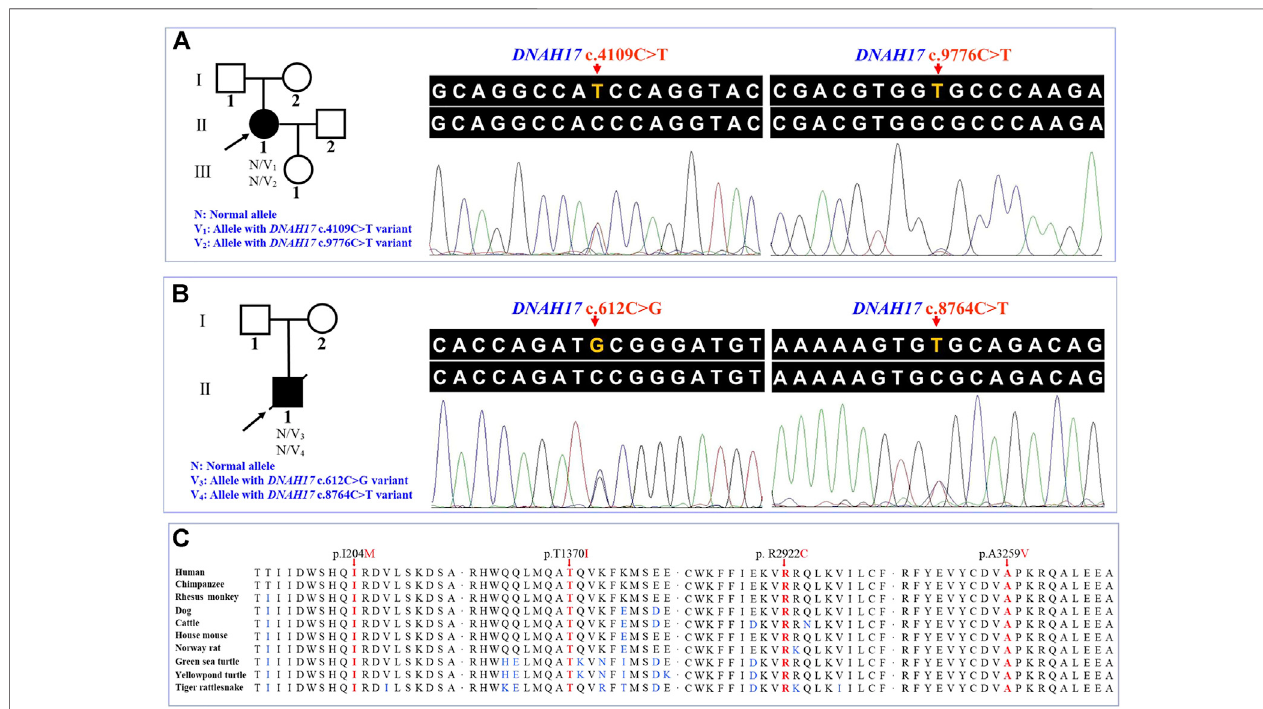
FIGURE 2 | Pedigrees and sequence analysis of the two unrelated Han-Chinese patients with left-right asymmetry disorders. (A) and (B) Pedigrees with left-right asymmetrydisordersandSangersequencingresults.Theproband,shownasasolidsymbol,isindicatedbyanarrow,andthedeceasedfamilymemberisshownwitha slash in the pedigree tree. (C) Sequence alignment of the dynein axonemal heavy chain 17 among different species, with the affected amino acids indicated by the arrows. DNAH17 , the dynein axonemal heavy chain 17